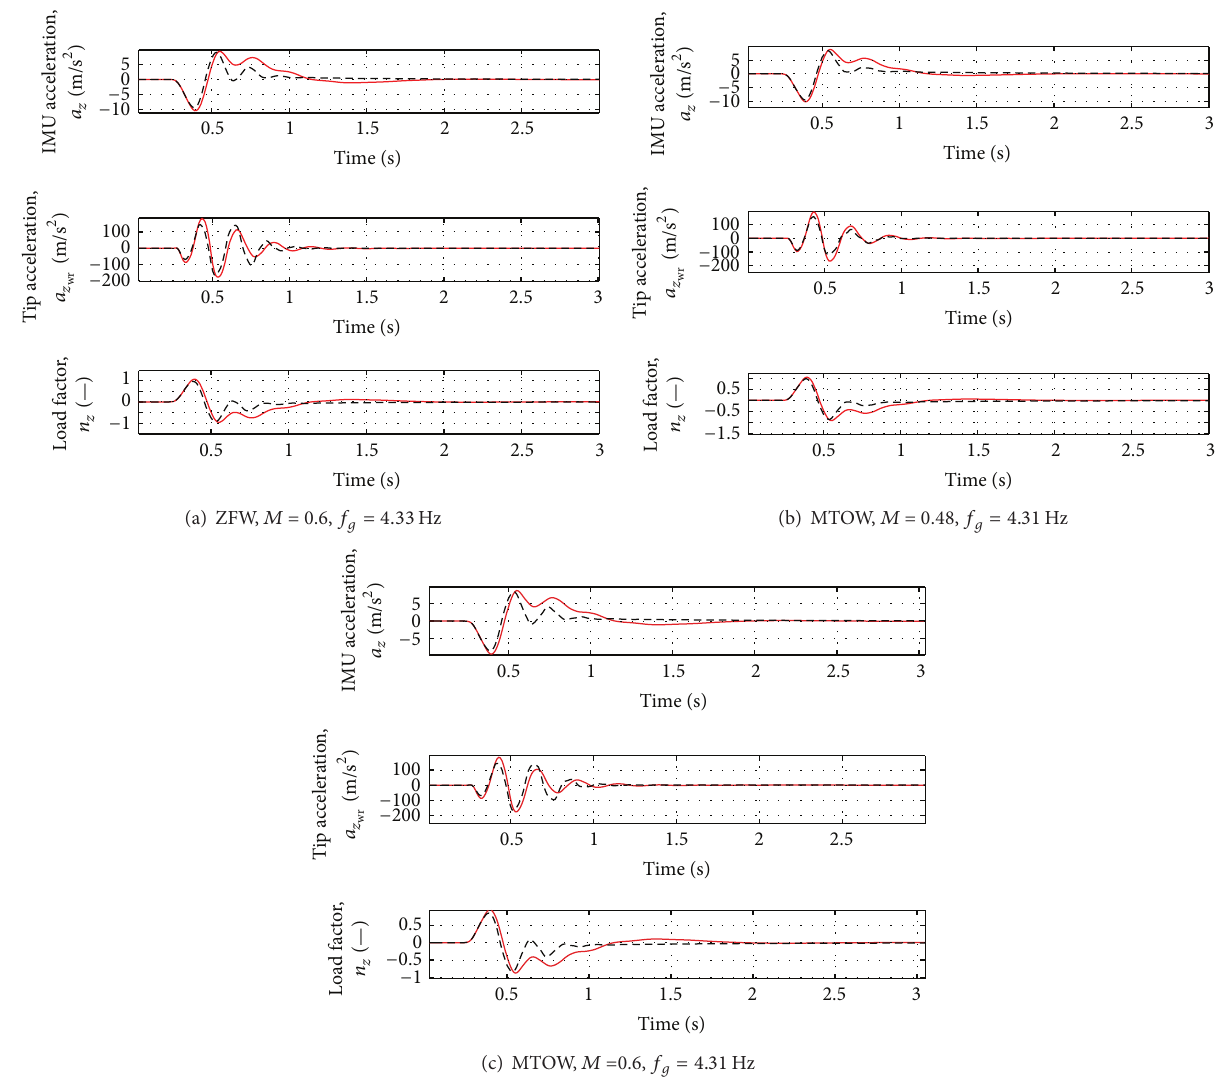
(c) MTOW, 𝑀 =0.6, 𝑓 𝑔 = 4.31 Hz Figure 10: Variation of acceleration and load factor for all the cases in Table 3. Red solid line: open loop, Black dotted line: closed loop.